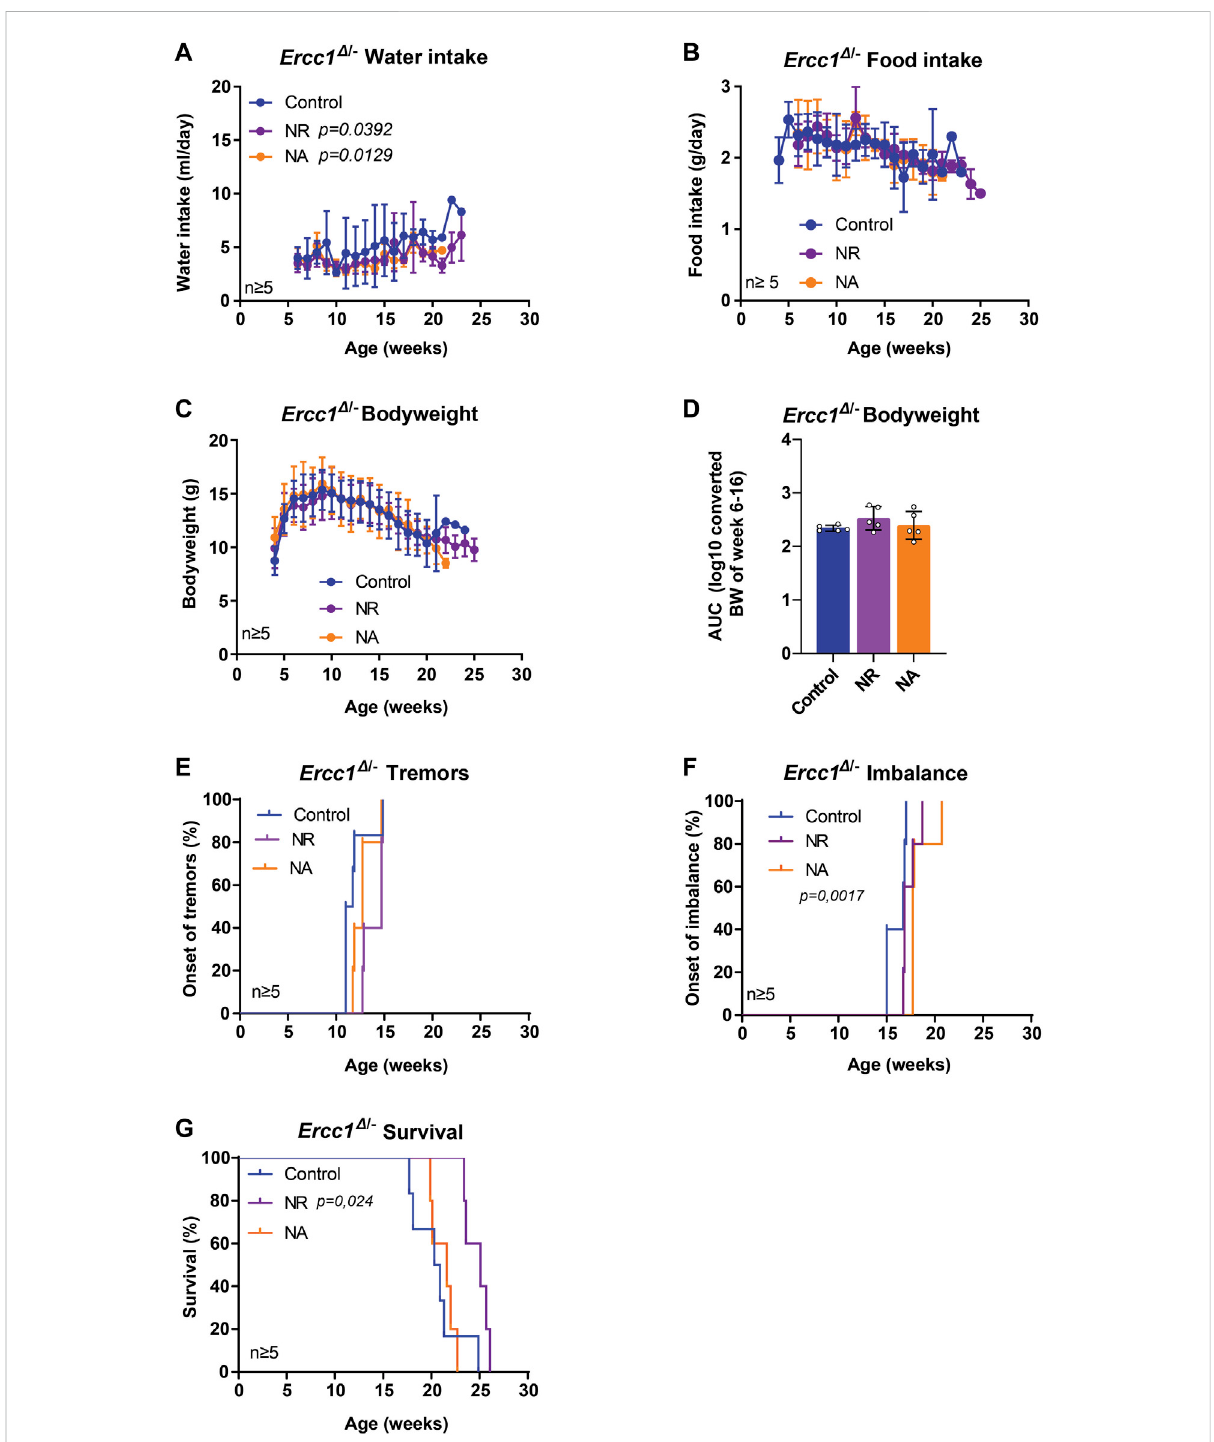
FIGURE 3 The effect of nicotinamide ribosome supplementation on the lifespan and onset of neurological phenotypes of Ercc1 Δ / − mice. (A – C) , Values of waterintake (A) ,foodintake (B) bodyweightchangesovertime (C) andbodyweightasareaunderthecurve(AUC) (D) incontrolanimalsandanimals receivingsupplementationoftwoNAD + precursors;NAandNR. (E – F) ,Onsetofneurologicalabnormalities;tremors (E) andimbalance (F) withageof Ercc1 Δ / − control mice and mice receiving NR or NA. (G) . Survival curve showing lifespan of the three groups. Indicated values are Mean (±SD). Signi fi cant p values of the Dunnet ’ s multiple comparison test (A) and log-rank survival test (F,G) are